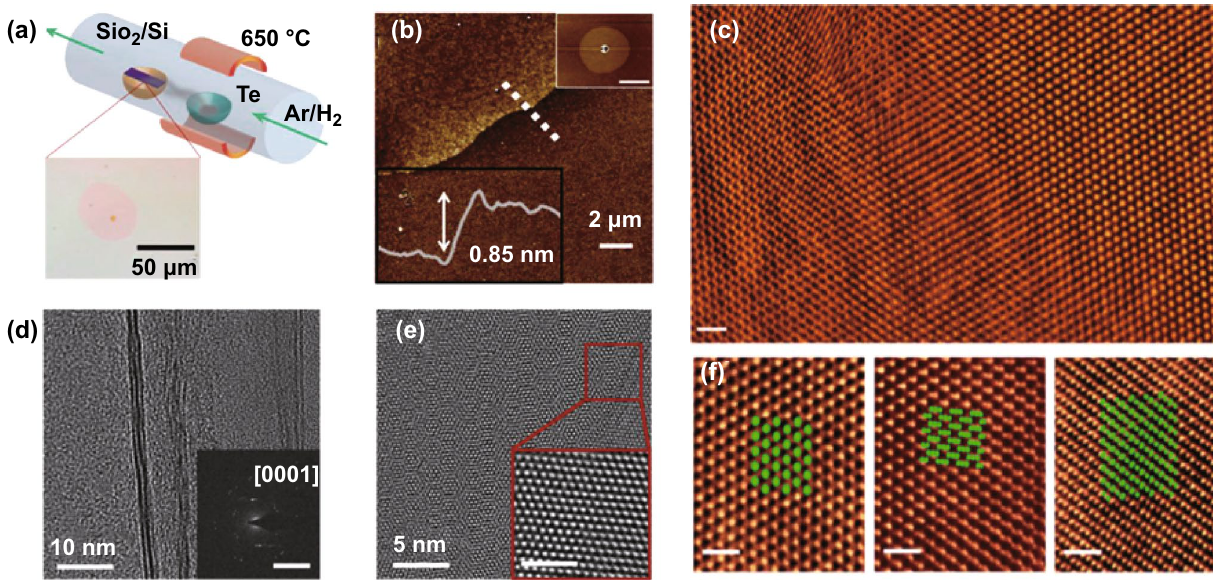
Fig. 2 Ultrathin Te flakes synthesized by PVD. a Schematic of the experimental setup. b Atomic force microscopy (AFM) image of the edge of a Te flake including a profile taken along the dotted line showing the thickness of the flake. c High‑angle annular dark‑field scanning transmis‑ sion electron microscopy (HAADF–STEM) image of Te flakes showing the large‑scale uniformity. d , e TEM images of Te flakes showing their structure measured by electron diffraction (inset of d ). f Atomically resolved HAADF–STEM images of the three Te polymorphs. Adapted